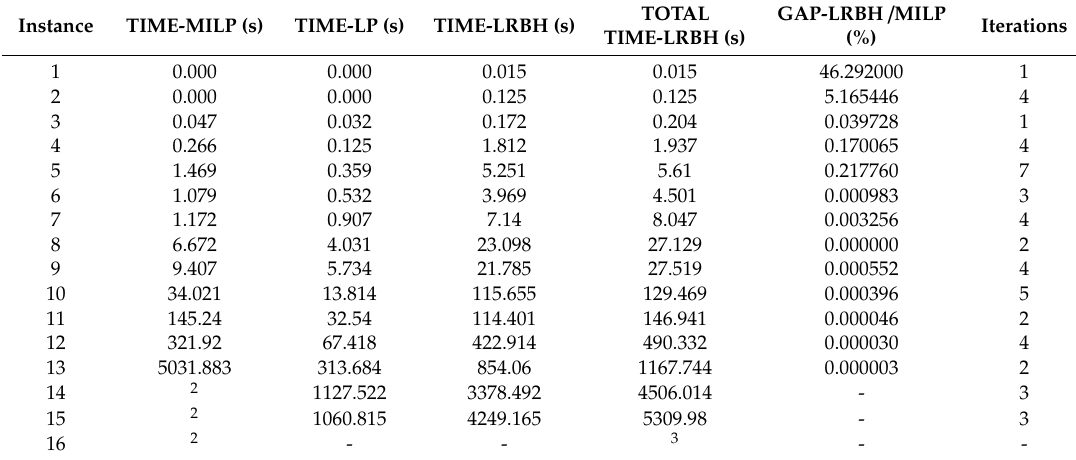
1 TIME is the processing time. 2 The CPLEX stopped due to being out of memory. 3 The Algorithm stopped due to exceeding 20,000 s.